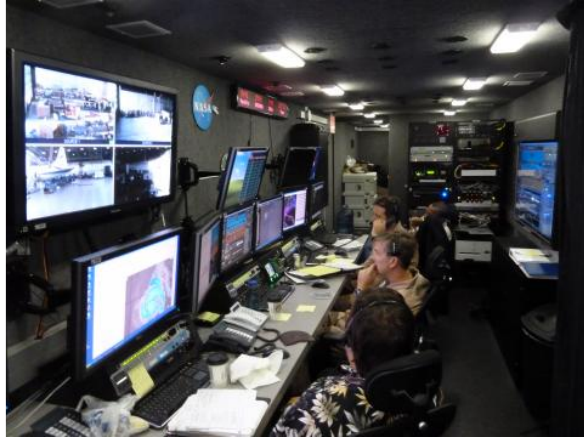
Figure 10. Global Hawk Operation Center (GHOC)